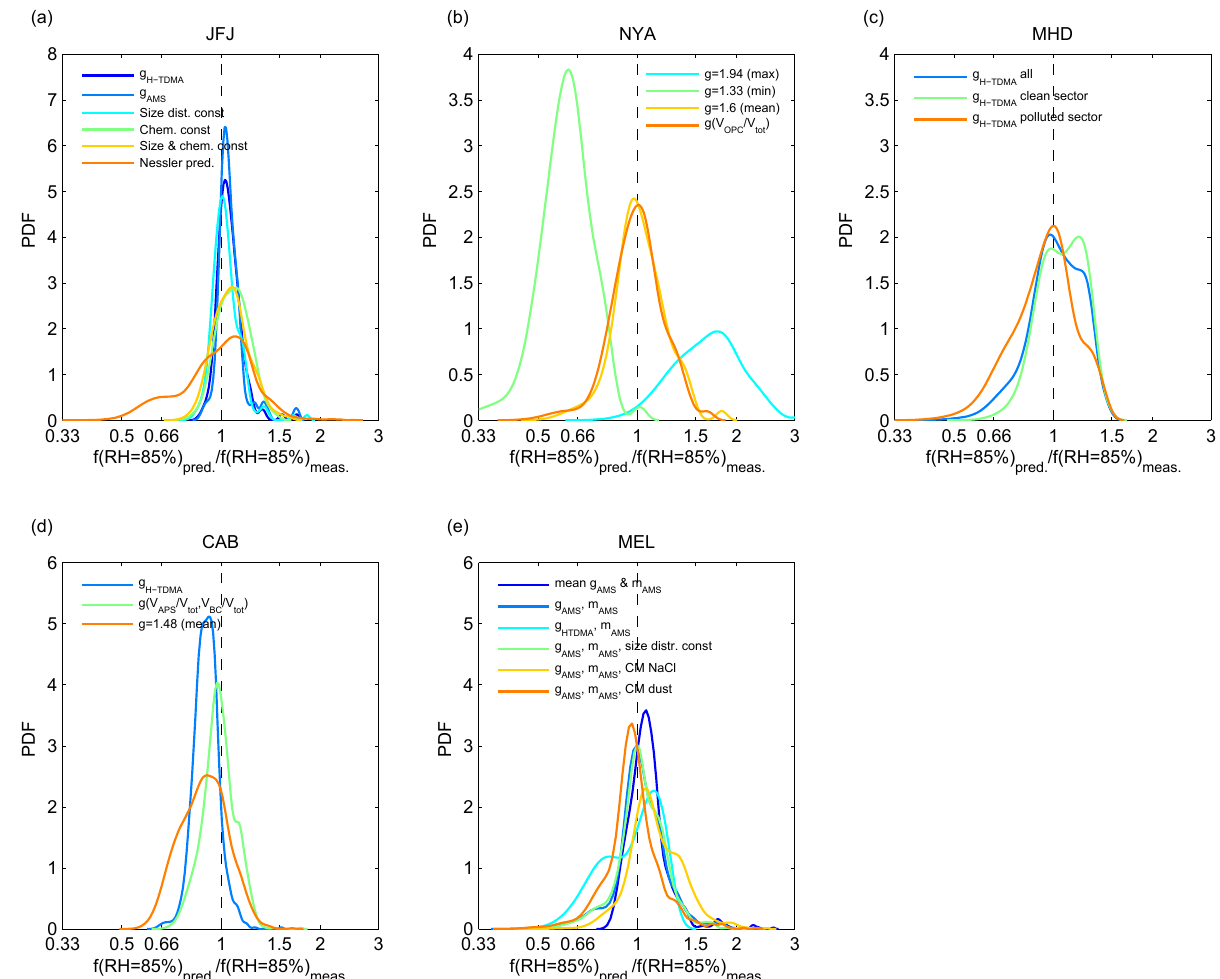
Fig. 6. Probability density function (PDF) of predicted to measured f (RH = 85%, 550nm) of the individual closure studies, which were characterized by their own specific settings (see text). g HTDMA denotes the hygroscopic growth factor measured by the H-TDMA, while g AMS is the calculated value from the chemical composition measurement of AMS and aethalometer or MAAP instrument. g(V OPC /V tot ) shows the result for a site-specific parameterization derived for Ny-Ålesund (NYA; see Zieger et al., 2010), while g(V APS /V tot ,V APS /V tot ) is a site-specific parameterization for Cabauw (CAB; see Zieger et al., 2011). m AMS denotes the particles’ complex refractive index derived from AMS and MAAP or aethalometer measurements. CM denotes the coarse